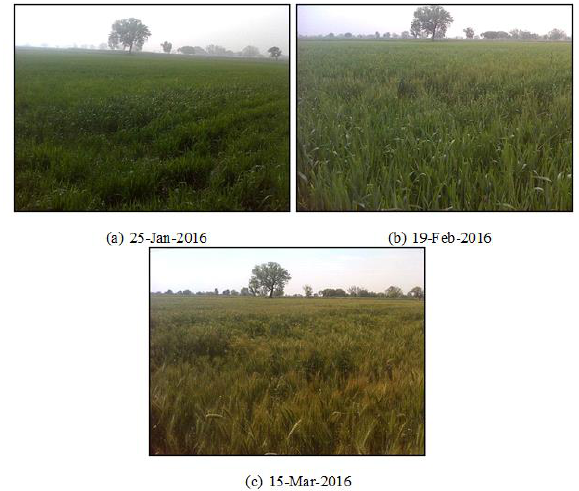
Figure 2. Ground-based photographs of a wheat field taken on (a) 25-Jan-2016 (b) 19-Feb-2016 and (c)